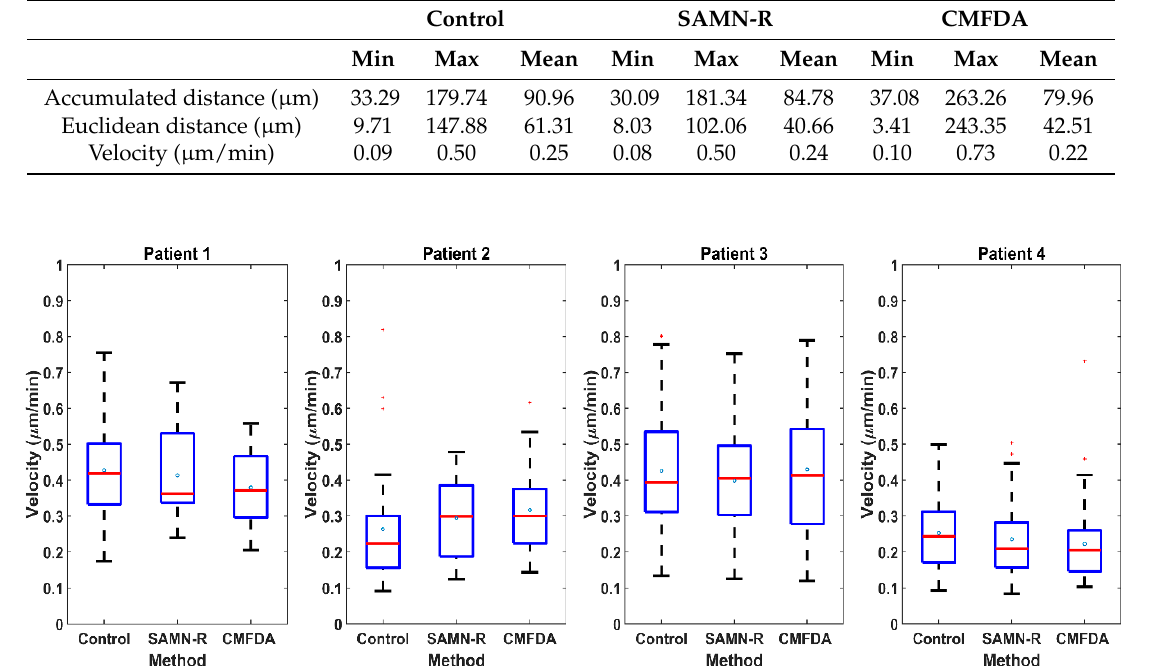
Figure 8. Calculated velocity from single hMSCs. Each box represents the complete set of single-cell velocities from four patients. There are 18 cells in each group from Patient 1, 30 cells from Patient 2, and 50 cells from Patients 3 and 4. Boxes are composed of main box edges (25th and 75th percentiles), blue dots (mean), central red horizontal line (median), whiskers (the most extreme values not considered outliers), and red squares (outliers).